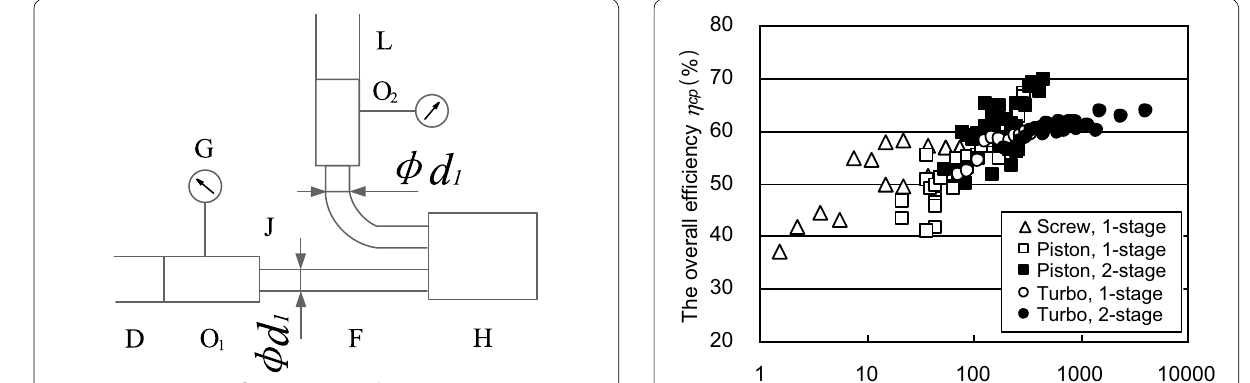
Figure 4 Connection of component under test to pressure-measuring connector using a bent tube or similar mechanism